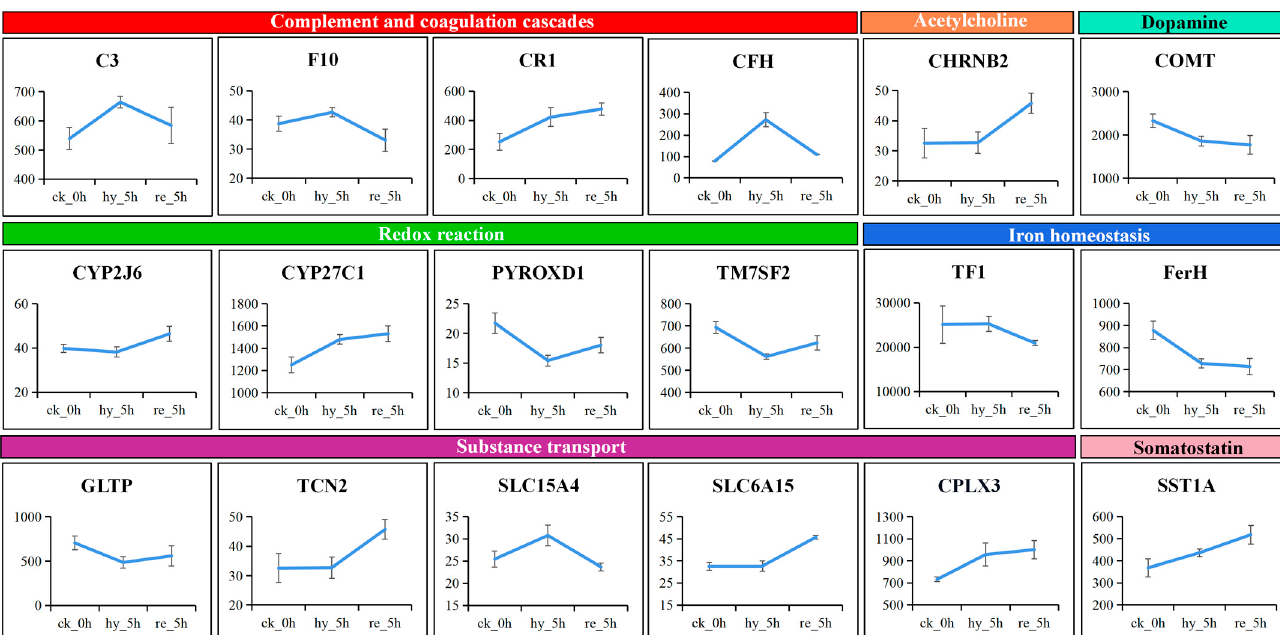
Figure 6. The changes in abundance of 18 DAPs in brain. The ordinate represents the TMT-based quantification values. They were classified according to their roles in immune response, iron home- ostasis, hormone and neurotransmitter synthesis, Redox reaction, and substance transport. DAP, differentially abundant protein.